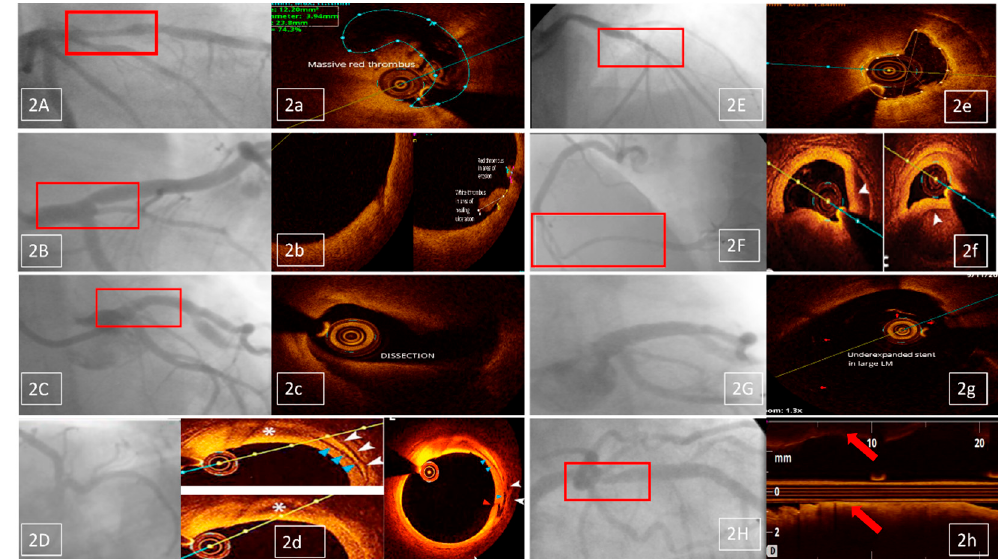
Figure 2. ( A )—Anterior STEMI previously treated with fibrinolytic therapy—angiographically borderline lesion on proximal LAD, a —OCT shows massive red thrombus, with significant lumen stenosis; ( B )—UA patient—angiographically nonsignificant lesion on ostial LAD, b —OCT shows signs of culprit lesion (white and red thrombus), with permeable lumen; ( C )—Anterior STEMI patient—ostial LAD haziness of nonsignificant lesion, c —OCT shows coronary dissection, with significant lumen stenosis; ( D )—Anterior STEMI patient—angiographically normal coronary aspect, d —OCT shows a dissection and hematoma originating from a vasa vasorum hemorrhage, being probably the underlying physiopathology of the ACS; ( E )—NSTEMI patient at 10 years after a LCX bare metal stent implantation—angiographically intra-stent haziness, e —OCT shows neoatherosclerosis as the mechanism for stent failure; ( F )—Inferior STEMI female patient—angiographically long, double lumen pattern, RCA stenosis, f —OCT confirms spontaneous dissection as the underlying physiopathology and guides PCI (guide wire presence in the true lumen and choice of stent’s “landing zones”); ( G )—LM PCI with excellent angiographic result, g —OCT shows significant malapposition; ( H )—Suboptimal angiographic result of proximal LAD stent placement, h —OCT shows excellent